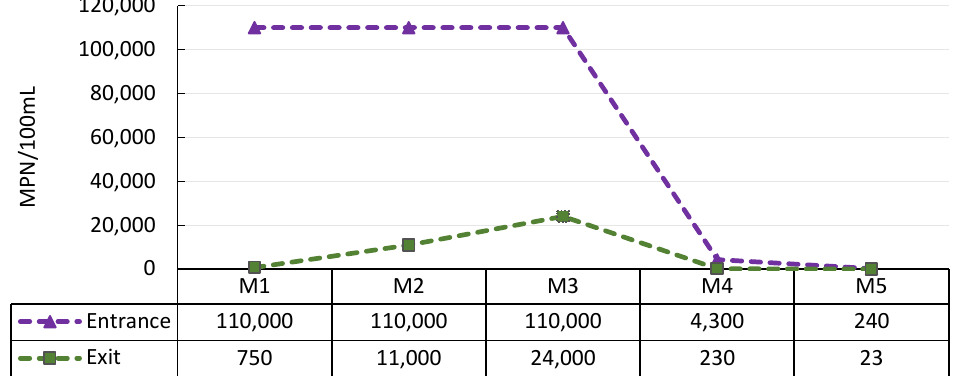
Fig. 9: Content of treated and untreated fecal coliforms in the 5